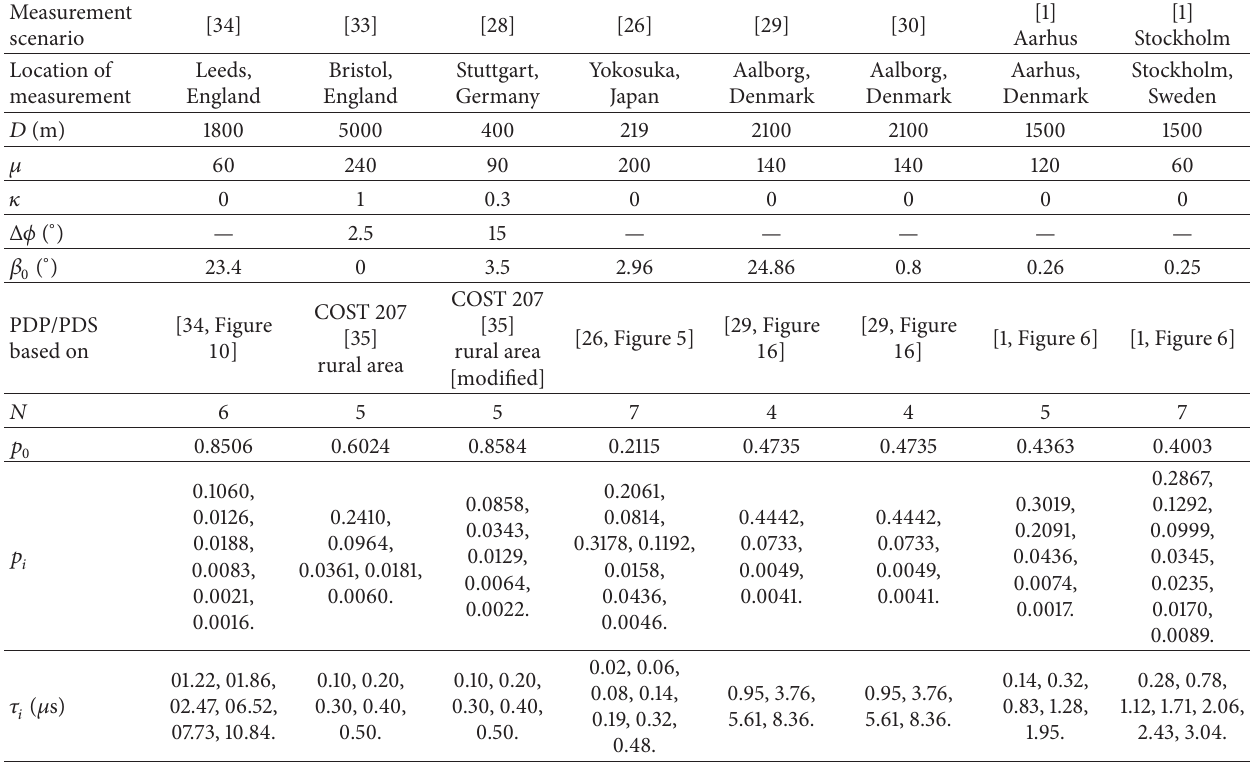
Table 4: Parameters of DBMM for analyzed measurement scenarios.